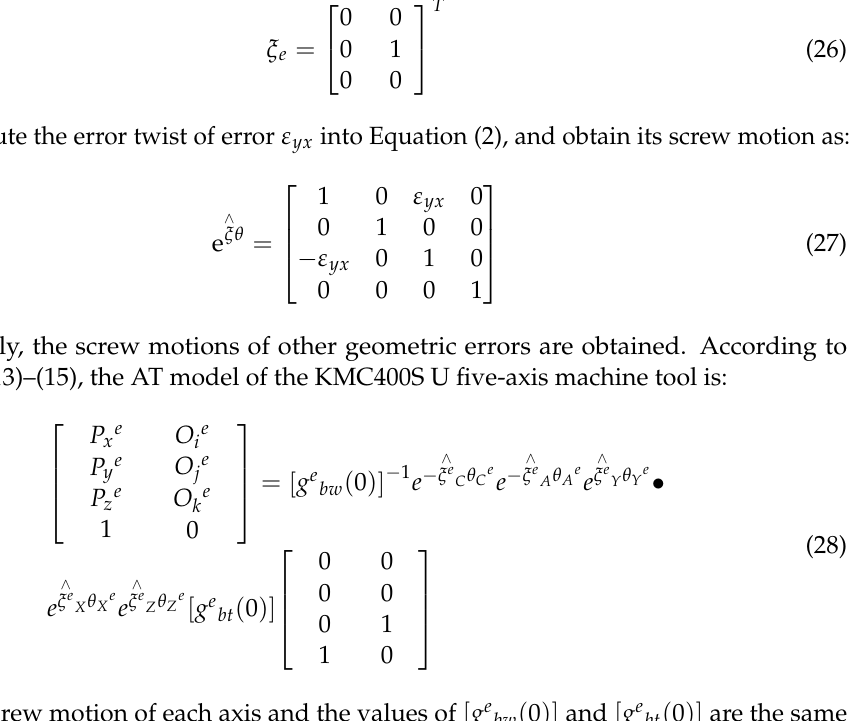
Figure 12. The error twist of the error